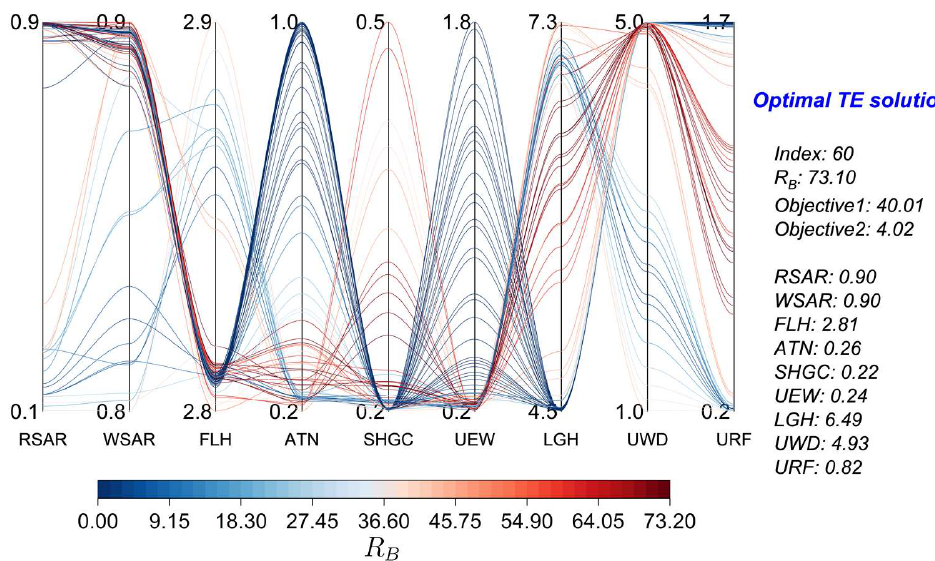
Figure 13. Evaluation and comparison of the technique-economy of 80 optimal parametric combinations by using R B .